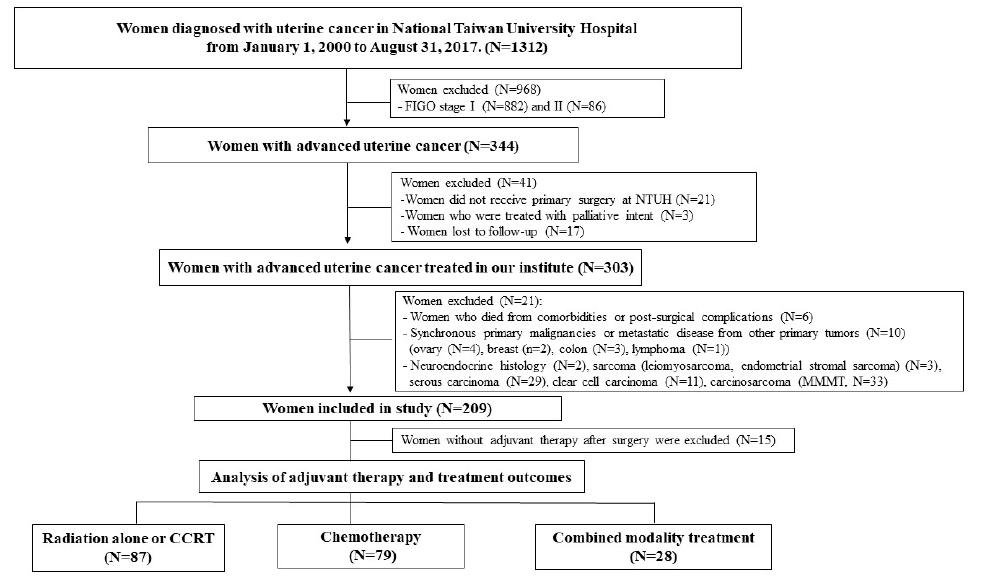
Figure 1. Flow chart of the study population.